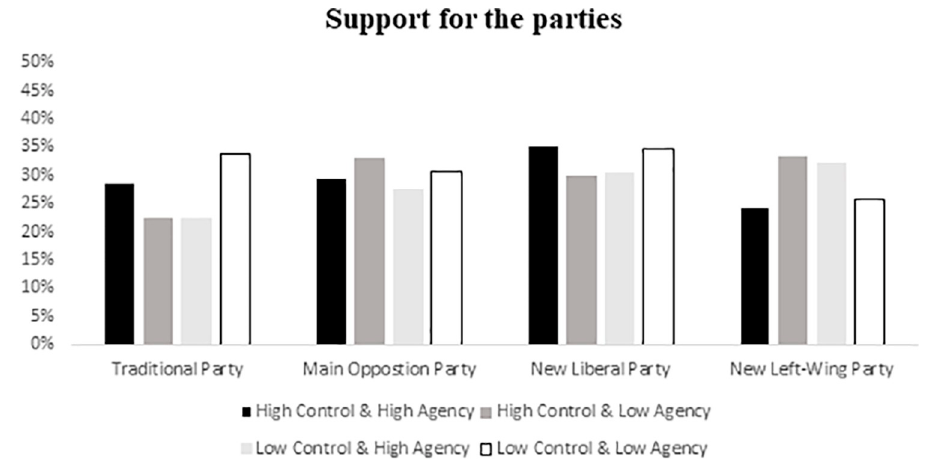
Fig 3. Support for the different political parties by experimental conditions.